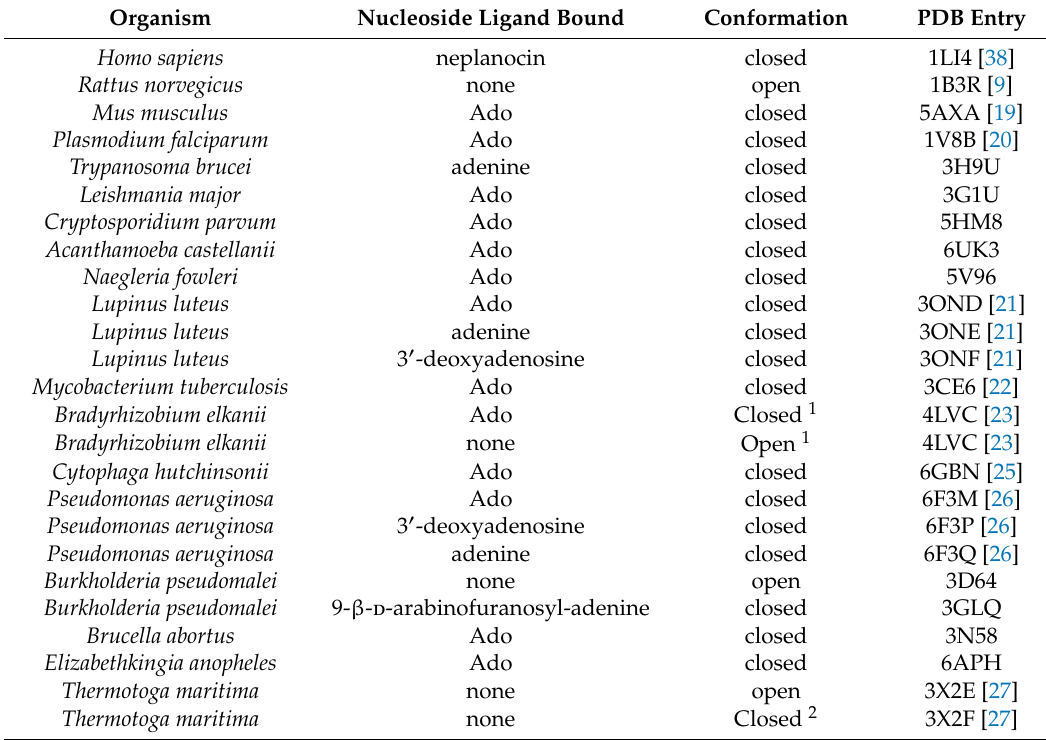
Table 1. Selected models of SAHases used in this study and their basic characterization, including a type of nucleoside bound in the substrate-binding domain of the enzyme, subunit conformation, and the code to Protein Databank (PDB)